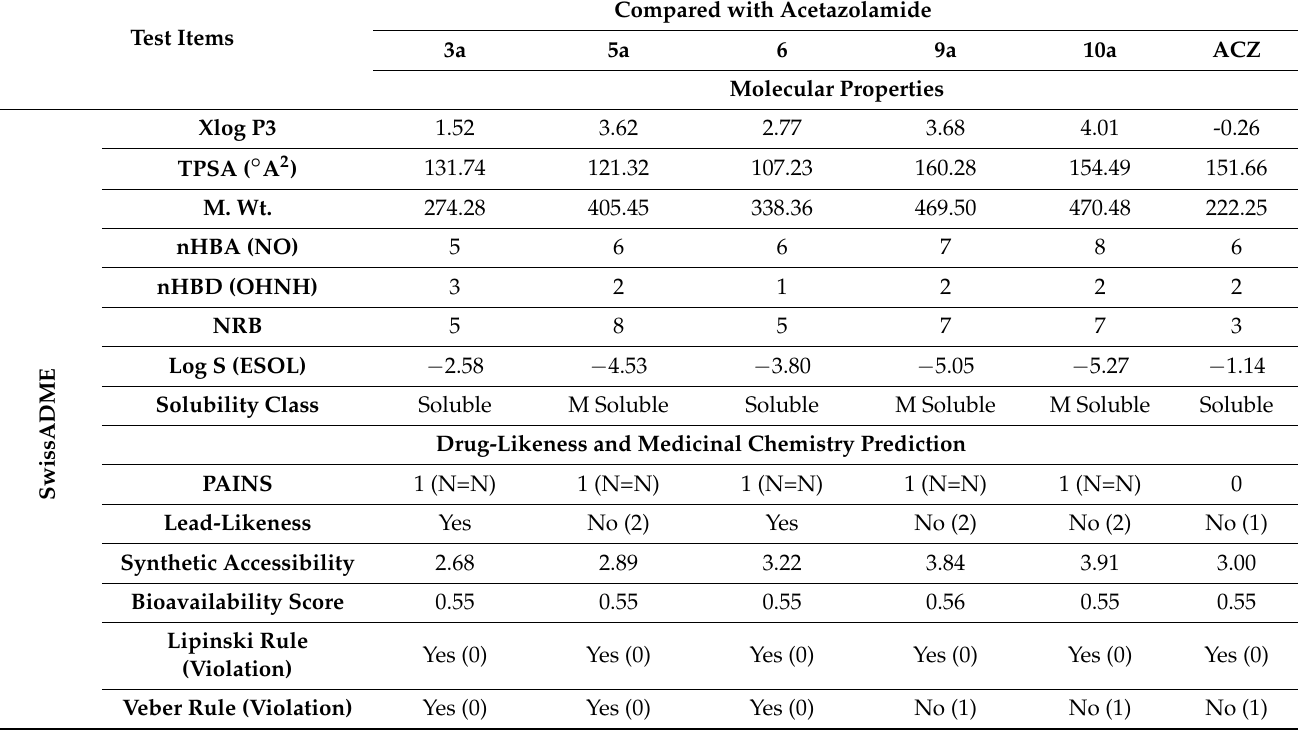
Table 6. Physicochemical properties, drug-likeness prediction, and medicinal chemistry of the most active pyrazole and pyrazolo[1,5- a ]pyrimidine derivatives compared with acetazolamide as positive